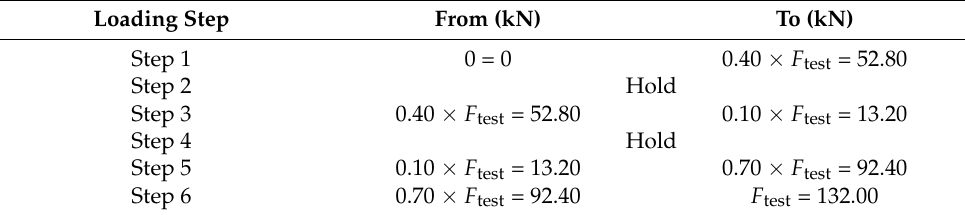
Table 2. The course of test of the experiment setup no. 2, full threaded screws.